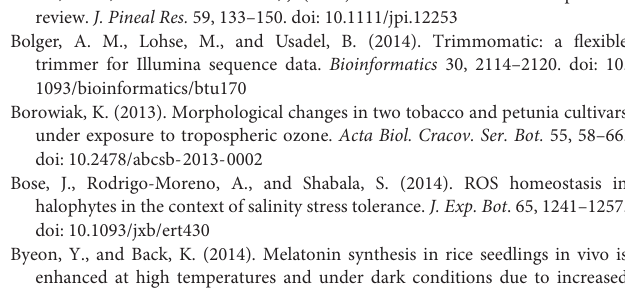
Supplementary Table 1 | Primers used in this study. Supplementary Table 2 | RNA-Seq profiles of grape leaves after different treatments, including control, O 3 , and MT + O 3 . The default condition for screening differences is P < 0.05 and fold change >